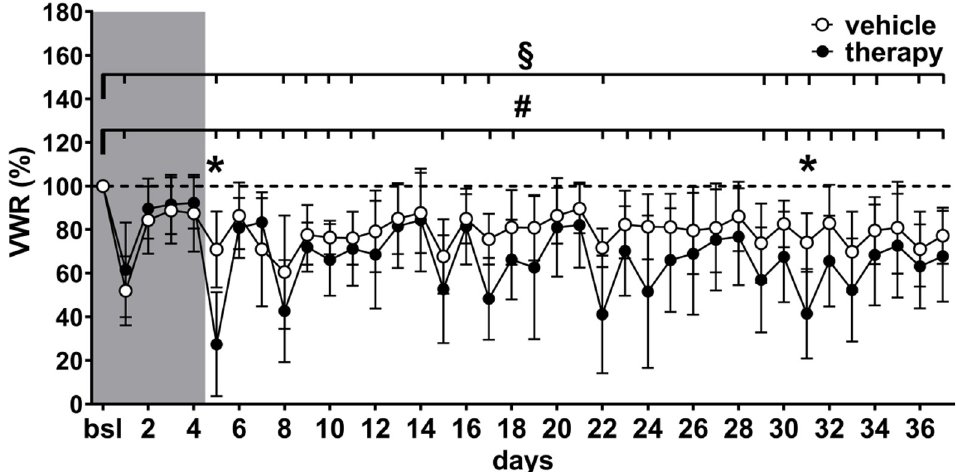
Fig 5. Course of VWR. VWR activity with days of significant differences between groups (day 5 and 31; � = comparison between both groups, linear mixed-effects model, fixed effects (type III) for group: p = 0.0927, F (1, 18) = 3.157 with Bonferroni‘s multiple comparisons test p < 0.05); compared to baseline, differences were detected in both groups, however, the frequency was higher in the therapy group (# = therapy, linear mixed-effects model, fixed effects type III: p < 0.0001, F (3.988, 35.90) = 13.12, Dunnett’s multiple comparisons test p < 0.05; § = vehicle, linear mixed- effects model, fixed effects type III: p < 0.0092, F (3.922, 32.12) = 4.068 Dunnett’s multiple comparisons test p <